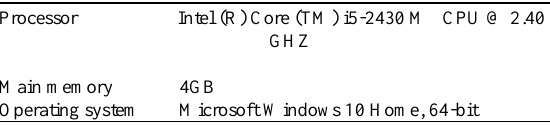
Table 2. System configuration used in the simulation.